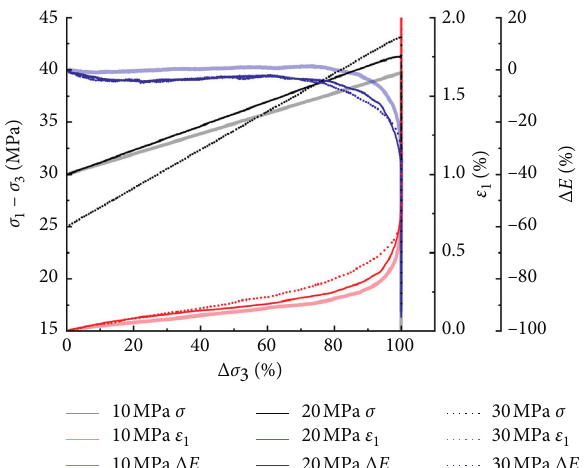
Figure 11: The relationship curve between Δ σ ( V u � 0.2 MPa/min).